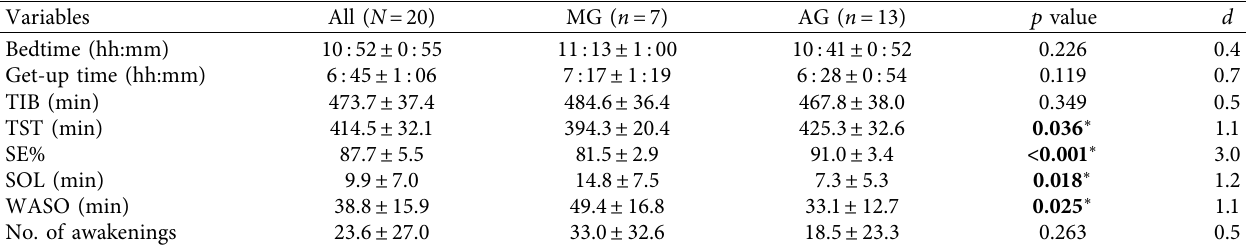
Table 4: Mean ± SD of sleep actigraphy data during the competitive phase in two groups of athletes considered as adapted and maladapted to